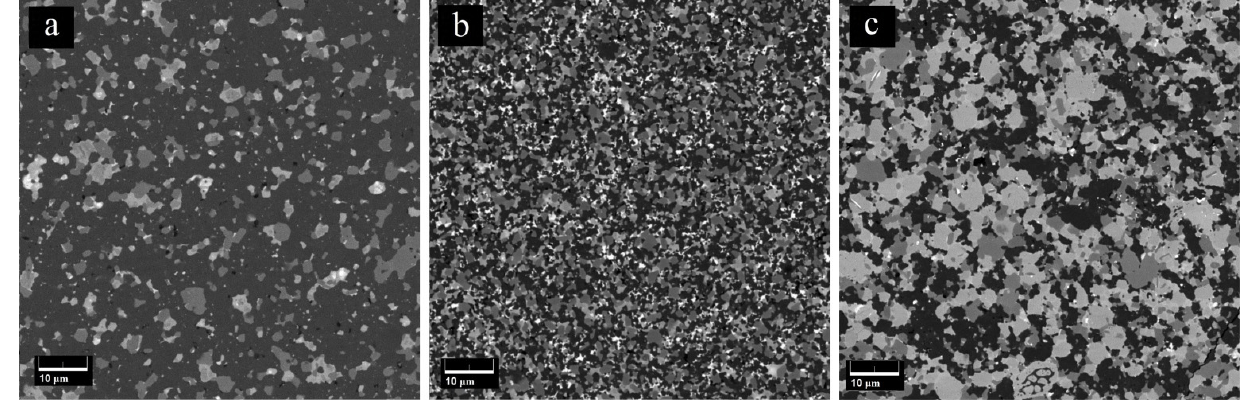
Figure 5. SEM images of the polished surfaces of ( a ) 80SiC, ( b ) 60SiC, and ( c ) 40SiC composites obtained by SPS.